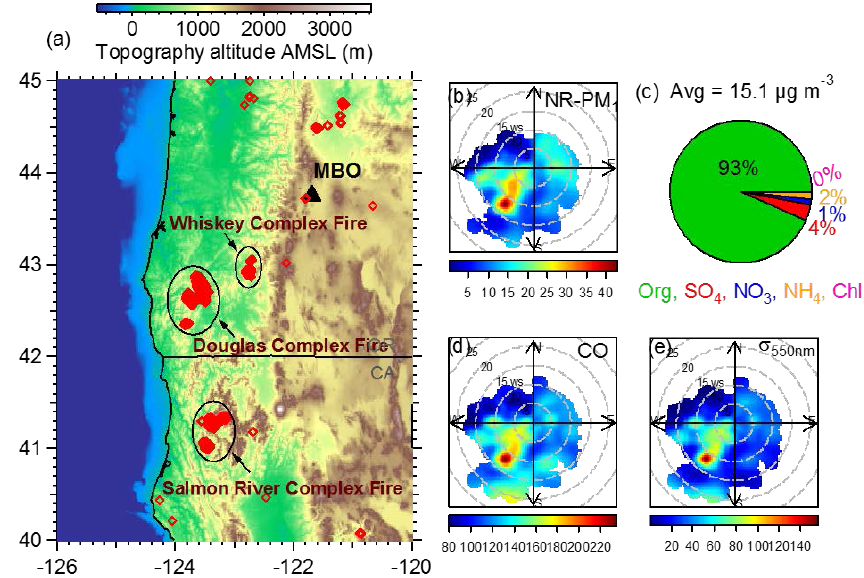
Figure 1. (a) Map with MBO (black solid triangle) and wildfires detected by MODIS (red open diamonds) in the US Pacific Northwest from 25 July to 25 August 2013. Three fire complexes – Whiskey Complex fire (WCF), Douglas Complex fire (DCF), and Salmon River Complex fire (SRCF) – are highlighted with black circles. Bivariate polar plots of (b) NR-PM 1 concentrations (inµgm − 3 ) , (d) submicrometer aerosol light scattering at 550nm ( σ 550nm in Mm − 1 ) , and (e) CO mixing ratio (in ppbv) during the sampling period. (c) Average NR-PM 1 composition for the sampling